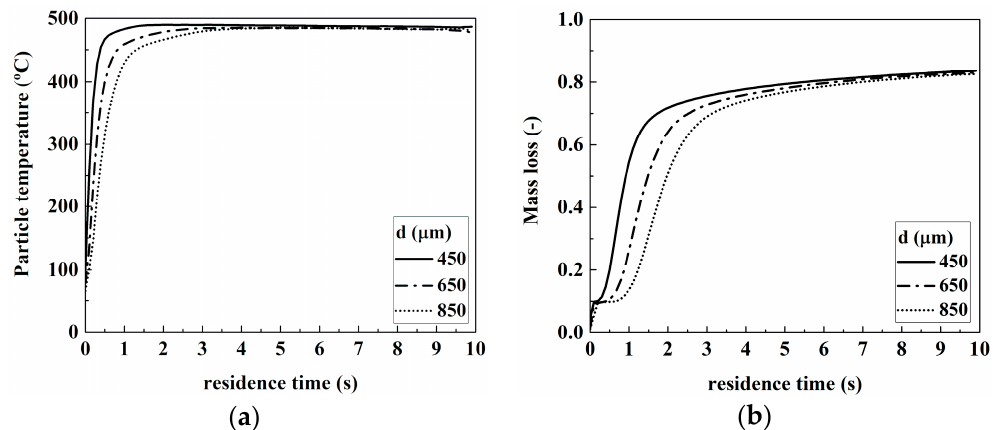
Figure 15. The average thermochemical conversion of biomass particles for different particle sizes: ( a )